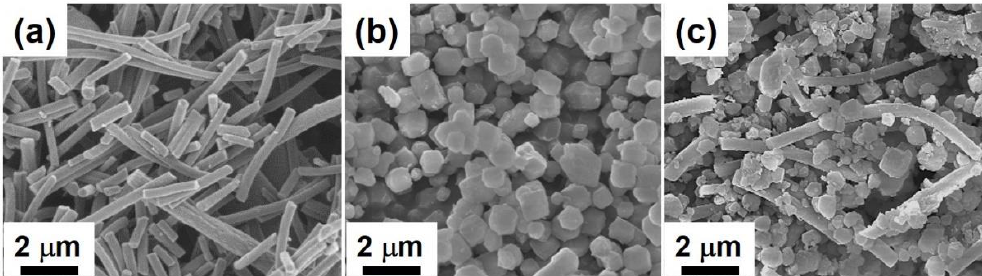
Figure 1. SEM images of ( a ) CNFs; ( b ) ZIF-67 nanocrystals; and ( c ) ZIF-67/CNFs composite.